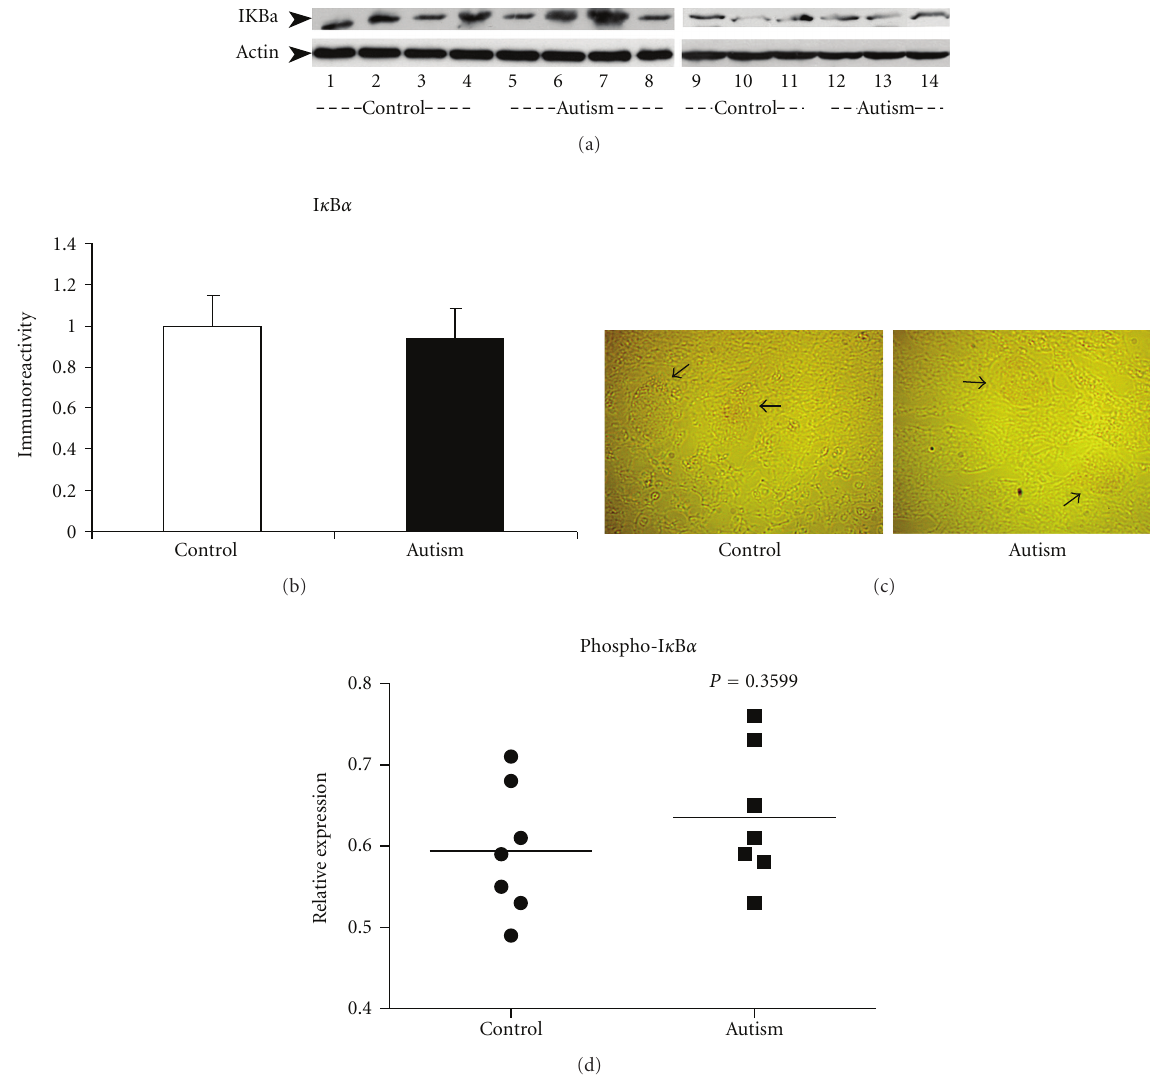
Figure 2: I κ B α inhibitory subunit expression in the cerebellum of autistic subjects. (a) Two independent western blot studies on cerebellar homogenates using I κ B α antibody (dilution 1 :1000). Lanes 1–4 and 9–11 represent the controls, and lanes 5–8 and 12–14 represent the autistic subjects. The upper panel shows actin bands (MW: 48kd), and the lower panel shows the I κ B α bands (MW: 35 kd). (b) Quantitative analysis after being normalized by actin. Data are shown as mean ± SE. White bars represent controls, and black bars represent autistic subjects. (c) Immunostaining of cerebellar sections using I κ B α antibody (dilution 1 :200). The expression of I κ B α shown as very faint red color was detected in the neural cells (indicated by arrows) in autistic cerebellum (right panel), as well as in the matched controls (left panel). The image is viewed under high power microscopy. (d) Measurement of phospho-I κ B α in the cerebellum of 7 autistic subjects and the age-matched controls with ELISA. P = 0 .